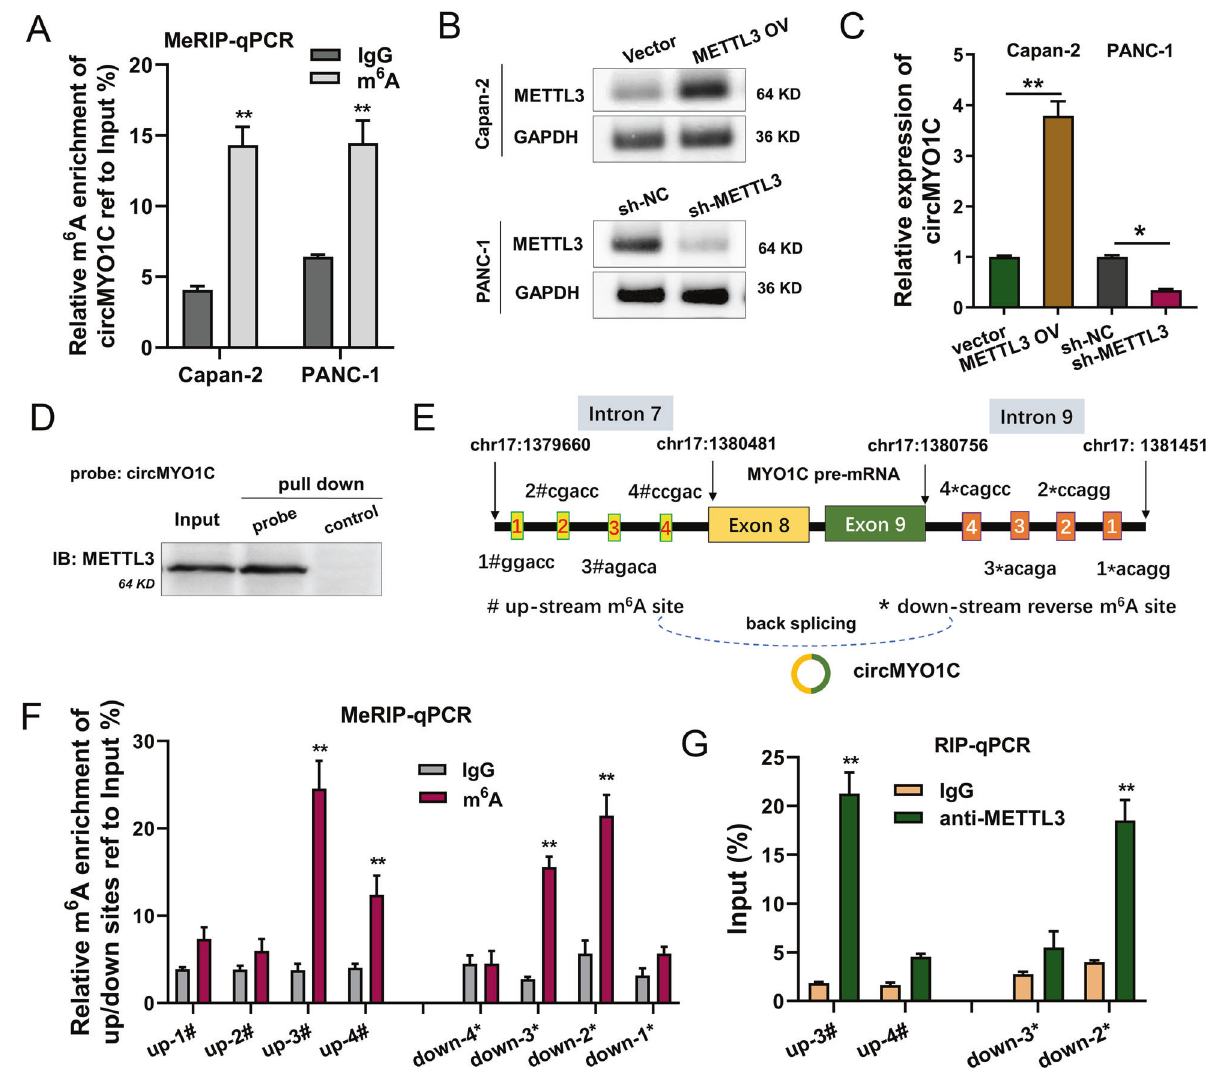
Fig. 3 METTL3 induced the circularization of circMYO1C via m 6 A-modi fi ed fl anking intron manner. A MeRIP-PCR analysis of m 6 A enrichment of circMYO1C in the PDAC cells (Capan-2, PANC-1). B Western blot analysis detected the METTL3 production in Capan-2 cells transfected with METTL3 overexpression and in PANC-1 cells transfected with METTL3 silencing. C RT-qPCR analysis detected the circMYO1C level in Capan-2 cells or PANC-1 cells transfected with METTL3 overexpression or silencing. D The interactions between METTL3 and circMYO1C was identi fi ed by RNA pull-down assays in Capan-2 cells using biotin-labeled circMYO1C probes. Western blots identi fi ed the pulled METTL3 protein. E Genomic schematic diagram displayed the potential m 6 A-modi fi ed sites in the upstream (intron 7) and reverse m 6 A sequence in downstream (intron 9). F MeRIP-PCR analysis detected the m6A enrichment of ruptured sequences n upstream (up-1#, up-2#, up- 3#, up-4#) and downstream (down-1*, down-2*, down-3*, down-4*). G RIP-qPCR assay using anti-METTL3 or anti-IgG illustrated the molecular binding of METTL3 with an upstream site (up#) and downstream site (down*). * p < 0.05 and ** p <